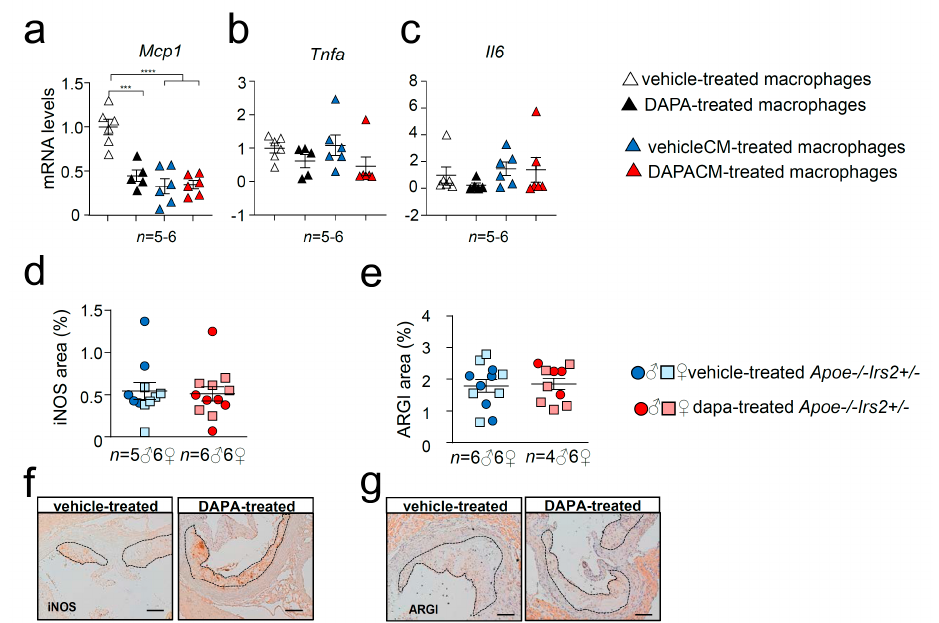
Figure 8. E ff ect of DAPA in Apoe − / − Irs2 +/ − mouse macrophage phenotype. mRNA expression of proinflammatory ( a ) Mcp1 , ( b ) Tnfa and ( c ) Il6 cytokines in Apoe − / − Irs2 +/ − macrophages treated with vehicle (vehicle-treated), 1 µ M of DAPA (DAPA-treated) or with conditioned media containing 10% of plasma from vehicle-treated mice (vehicleCM) or with conditioned media containing 10% of plasma from DAPA-treated mice (DAPACM). ( d ) iNOS and ( e ) ARGI lesional content in aortic cross-sections from vehicle- and DAPA-treated male and female mice, determined as percentage of positive stained area relative to lesion area. Representative images of the ( f ) iNOS, and ( g ) ARGI, stainings used for the quantifications are shown. Scale bar: 100 µ m. The lesion is limited by dashed lines. The statistical analysis for normal distribution was Kolmogorov–Smirnov test and for di ff erences was one-way ANOVA followed by Tukey’s multiple comparison test (panel a ), Kruskal–Wallis followed by Dunn’s multiple comparison test (panels b , c ) and Mann–Whitney U test (panels d , e ). *** p < 0.001; **** p < 0.0001.